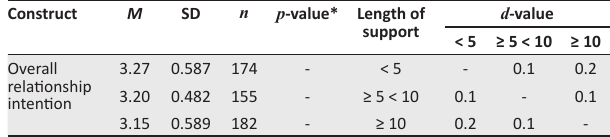
TABLE 6: Effect sizes on overall relationship intention and duration of support.